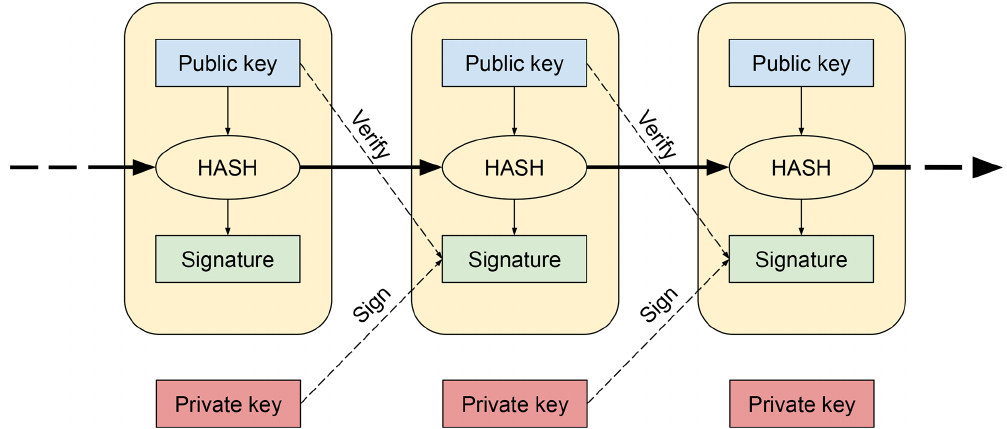
Figure 1. Diagram of three consecutive blocks (two transactions) within a blockchain.